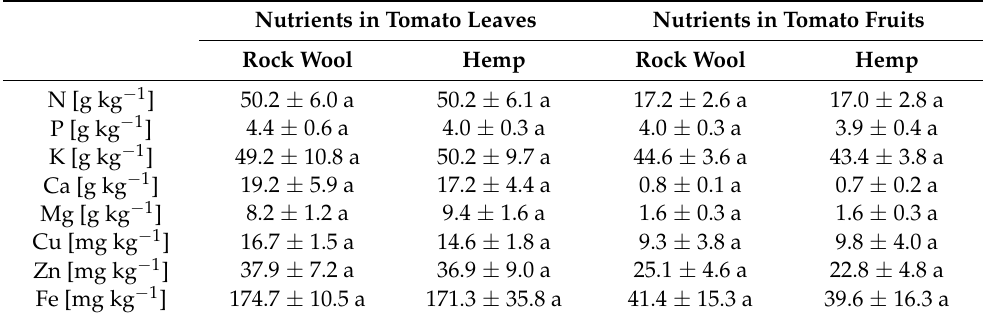
Table 5. Nutrient contents in tomato leaves and fruits in relation to different substrates. Nutrients in Tomato Leaves Nutrients in Tomato Fruits Rock Wool Hemp Rock Wool